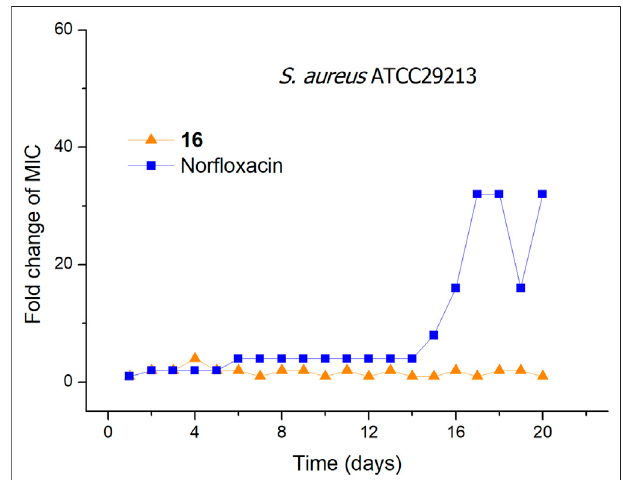
FIGURE 2 | Bacterial resistance studies of compound 16 and nor fl oxacin against S. aureus